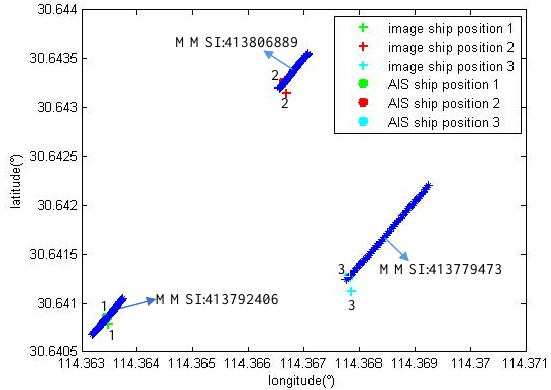
Figure 13. The results of the point to track matching algorithm for the identification of three vessels.